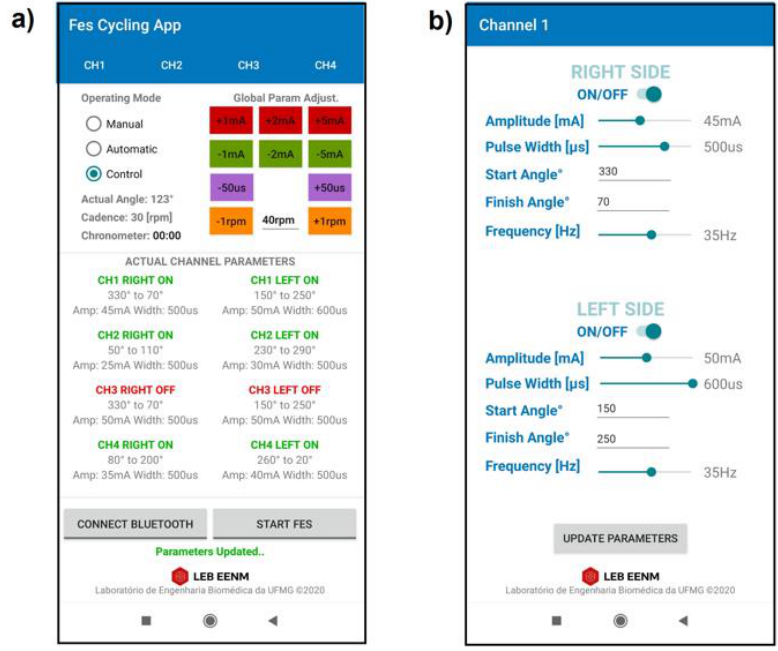
Figure 5. Proprietary mobile application developed for system configuration. ( a ) Main screen displaying real-time data and parameters for Manual , Automatic , and Control modes; ( b ) channel screen used for parameter configuration (channel 1).